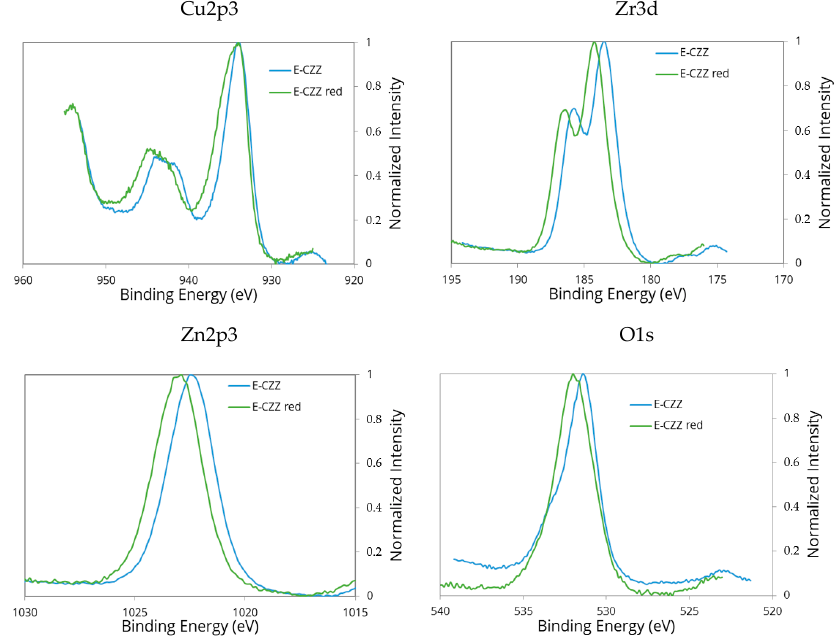
Figure 4. Cu2p 3 / 2 -, Zn2p 3 / 2 -, Zr3d 5 / 2 -, and O1s-lines in the XPS spectra of the calcined (blue) and reduced Figure 4. Cu2p 3/2 -, Zn2p 3/2 -, Zr3d 5/2 -, and O1s-lines in the XPS spectra of the calcined (blue) and E-CCZ sample (green). Molecules 2020 , 25 , x FOR PEER REVIEW reduced E-CCZ sample (green).